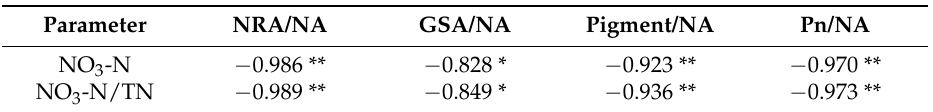
Table 2. Correlation coefficients between nitrate content and enzymes of nitrogen assimilation, pigment content in